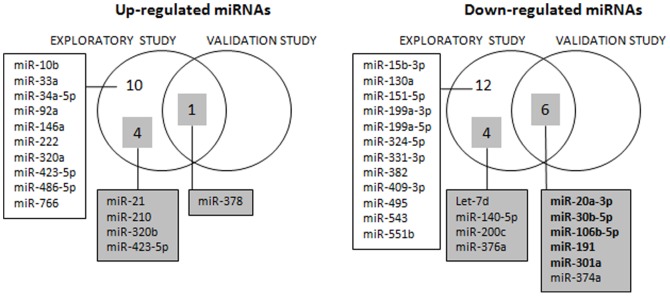
Venn diagram showing up-regulated and down-regulated miRNAs in the exploratory screening and the validation study.In the exploratory screening, there were in total 37 circulating miRNAs exhibiting age-related expression (p<0.05). Of those, only the top-15 miRNAs with the lowest p-values (shown in grey boxes) were further investigated in the validation study. Seven age-related miRNAs were confirmed in the validation study (p<0.05), of which 5 (all showing decreased expression) remained significant after correction for multiple testing; these are indicated in bold. Obviously, the right-hand zone (i.e. miRNAs showing altered expression in the validation study but not the exploratory screening) cannot contain any miRNAs, since the validation study only included those miRNAs that emerged from the exploratory study as the most significantly age-related ones.